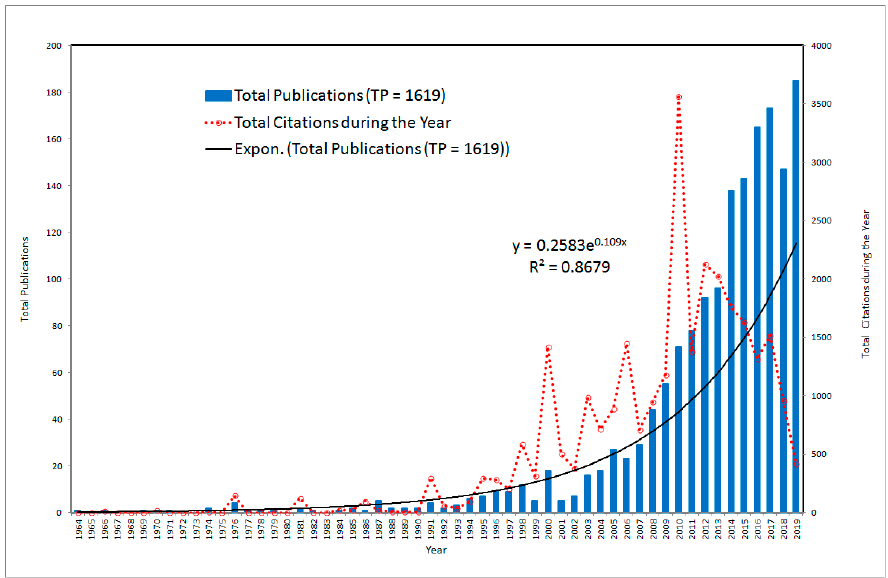
Figure 2. Year-wise research production and their total citation.